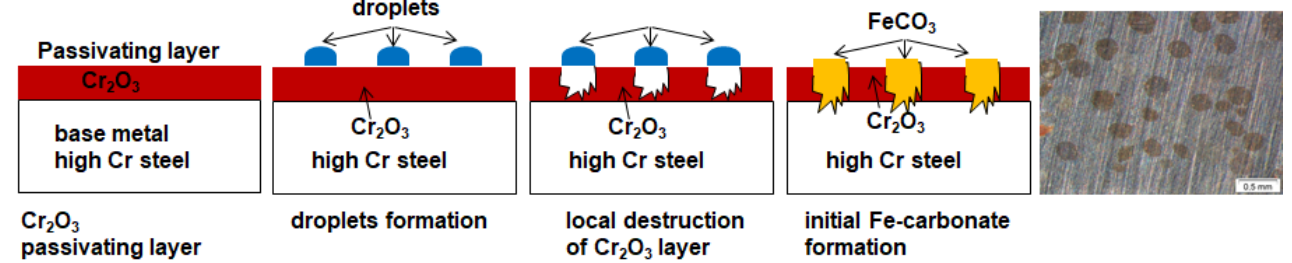
Figure 9. Schematic cross-section illustration of the corrosion procedure to form the leopard structured corrosion scale consisting of siderite FeCO 3 on 16–17% Cr high alloyed stainless steels X35CrMo17 and X5CrNi CuNb16-4. Reprintetd with permission from [16]. 2021 MDPI, A. Pfennig.